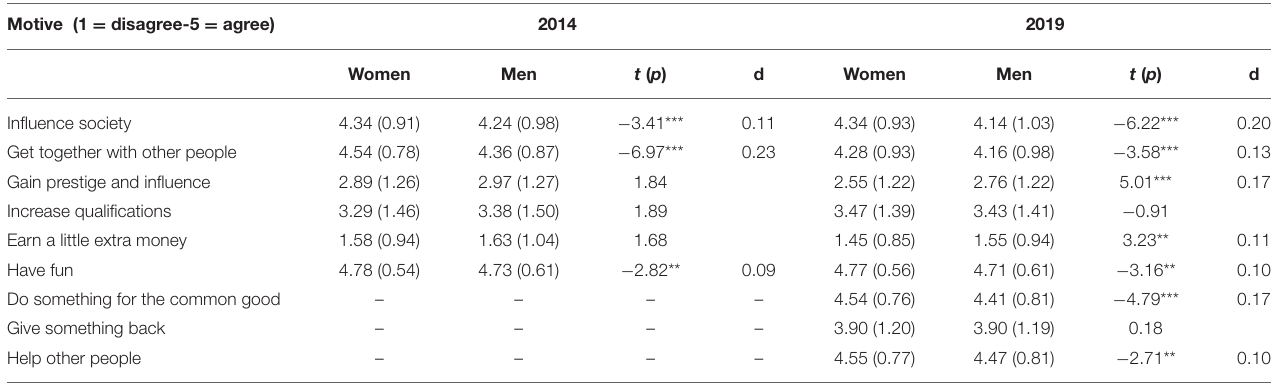
TABLE 4 | Reasons to volunteer, differentiated by gender and survey period.